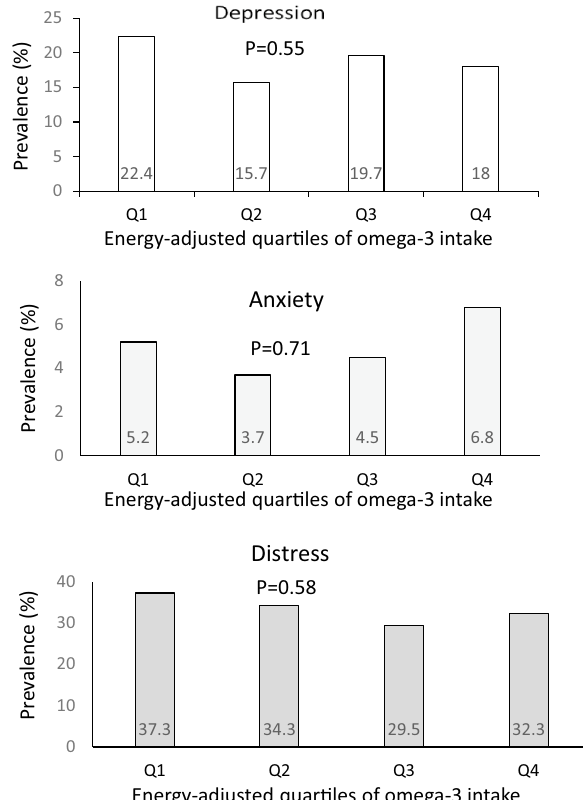
Figure 2. Prevalence of psychological disorders across energy-adjusted quartiles of omega-3